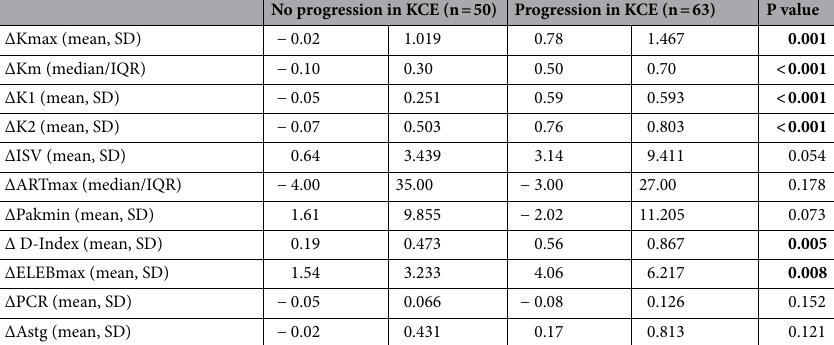
Table 3. Variation of different progression parameters between measurements (12 ± 3 months apart) in groups with or without KCE progression. KCE keratoconus enlargement, Kmax maximum keratometry, Km mean keratometry, K1 keratometry of flat meridian, K2 keratometry of steepest meridian, ISV index of surface variance, ARTmax Ambrósio relational thickness maximum, PachyMin minimum pachymetry, D-Index Belin/ Ambrósio D-Index, ELEBmax maximum elevation of corneal back surface, PCR posterior radius of curvature from the 3.0 mm centered on the thinnest point, Astig corneal astigmatism, Δ represents the variations of parameter readings between the first and the second measurement after 12 ± 3